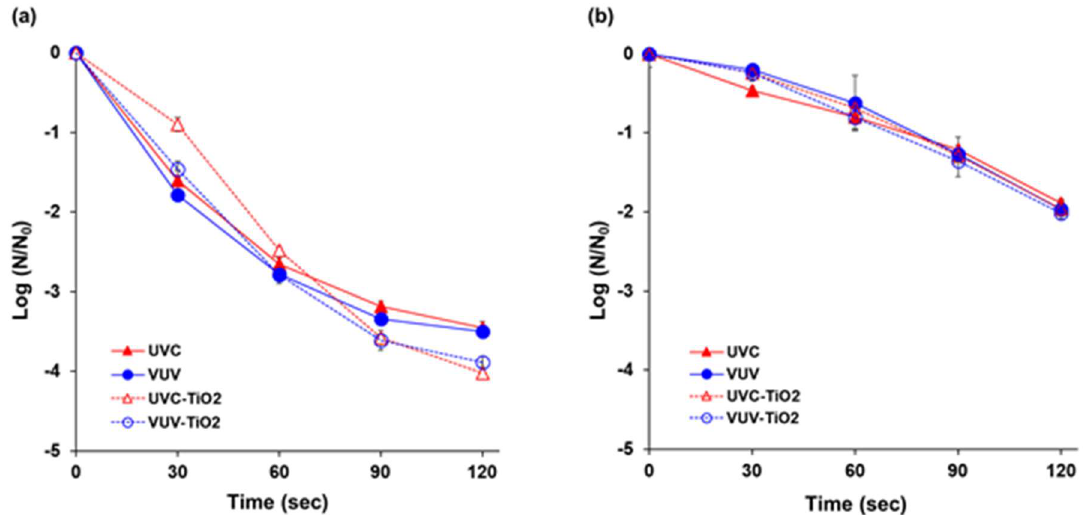
Figure 5. E ff ects of the UV light source and TiO 2 photocatalytic on inactivation of microorganisms in aqueous media. ( a ) E. coli K12; ( b ) Saccharomyces cerevisiae . UVC = UVC (254 nm) photolytic treatment; VUV = VUV (254 nm and 185 nm) photolytic treatment; UVC-TiO 2 = UVC-assisted TiO 2 photocatalytic treatment; VUV-TiO 2 = VUV-assisted TiO 2 photocatalytic treatment. The N 0 of E. coli K12 and S. cerevisiae were 6.9 and 5.3 log CFU / mL, respectively. All of the treatments were performed under extra aeration. Results represent the mean of three measurements ± standard deviation.